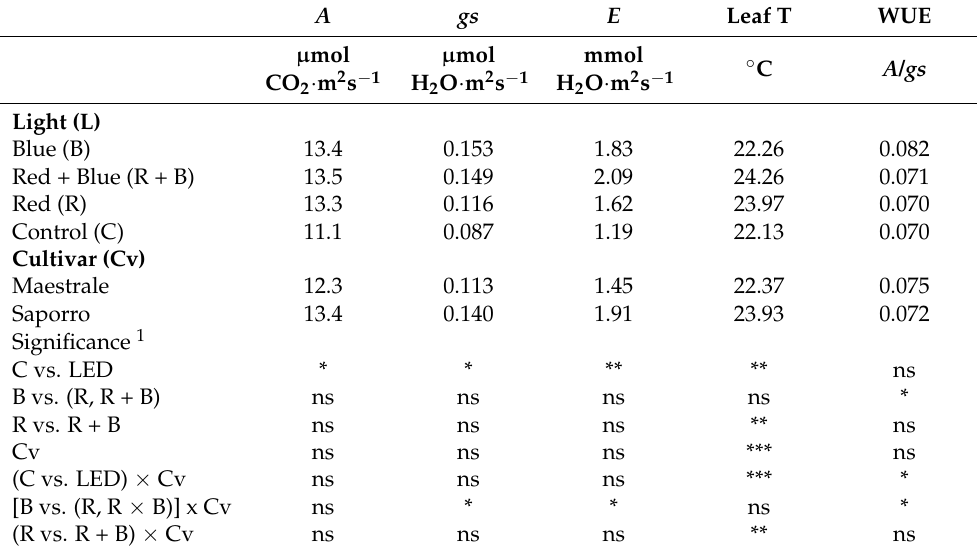
Table 4. Effects of light spectra and cultivar on photosynthesis rate ( A ), stomatal conductance ( gs ), transpiration rate ( E ), leaf temperature (Leaf T) and water use efficiency (WUE) of green